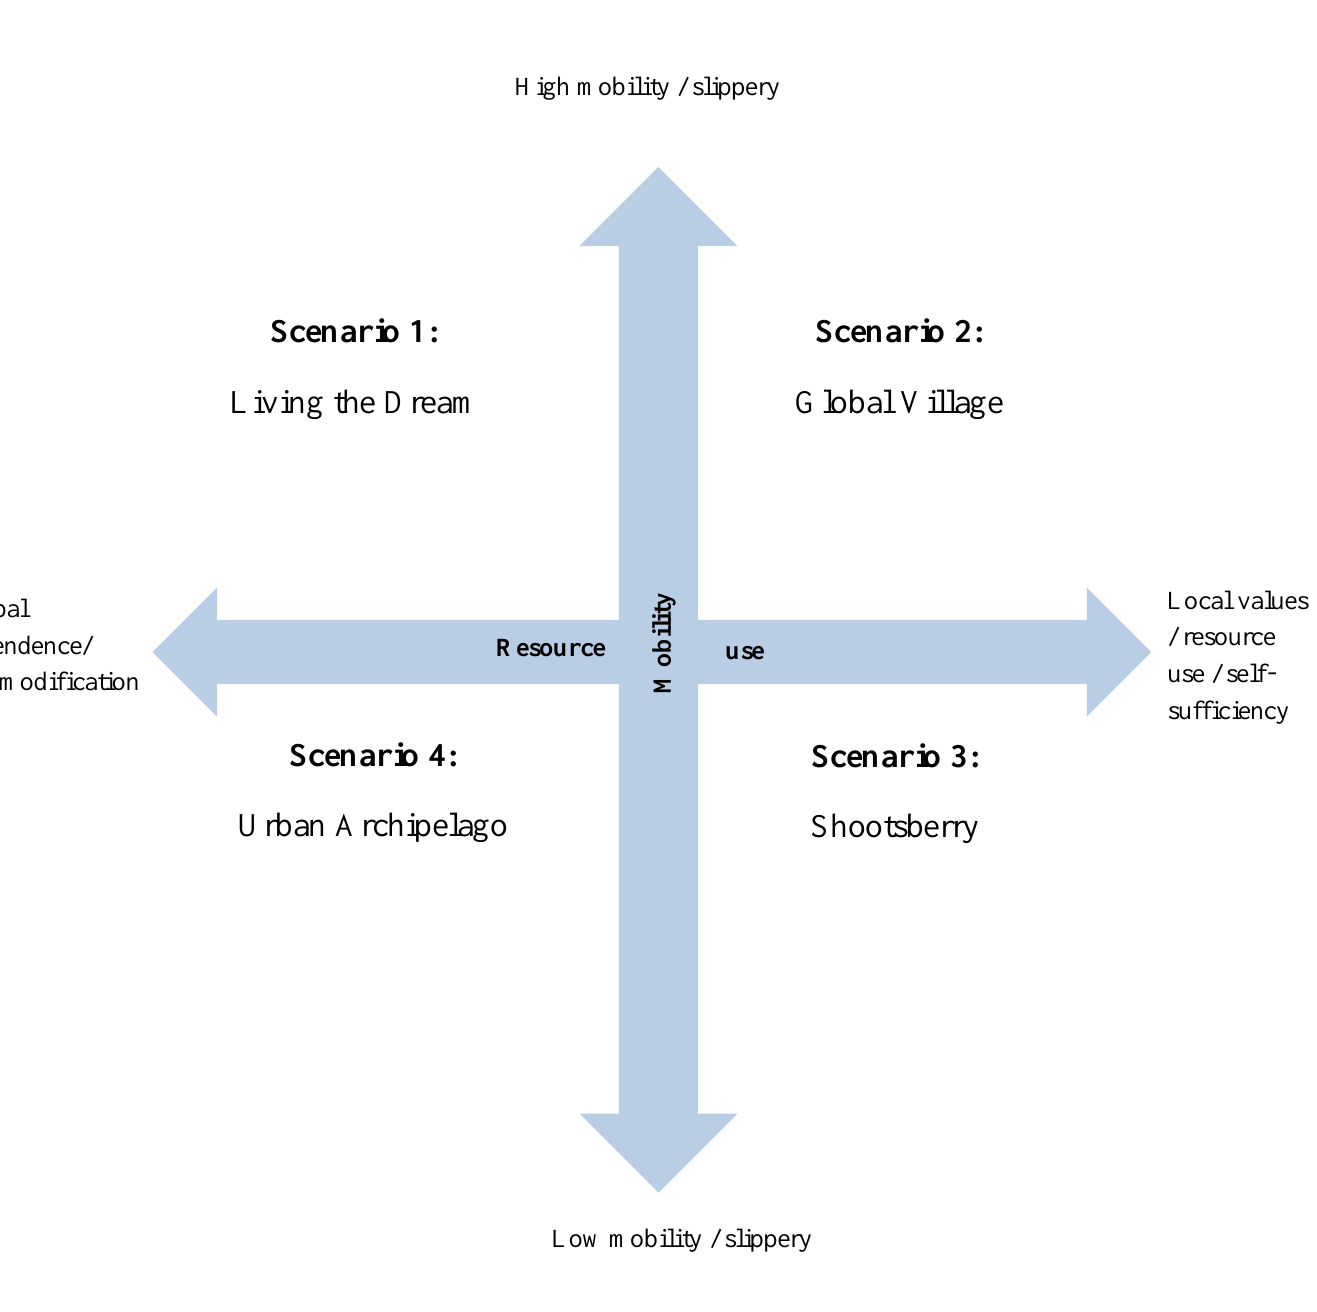
Fig. A2.2. Massachusetts scenario